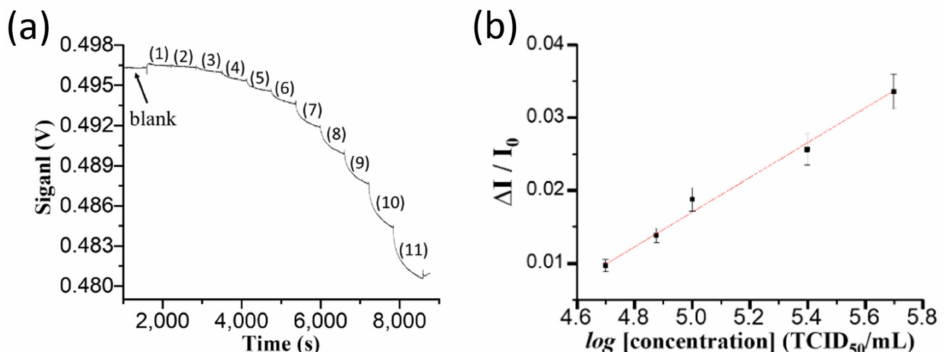
Figure 2. ( a ) The sensorgram obtained by sequentially injecting NNV standard solutions at concentra- tion of (1) 1.0 × 10 3 , (2) 2.5 × 10 3 , (3) 5.0 × 10 3 , (4) 7.5 × 10 3 , (5) 1.0 × 10 4 , (6) 2.5 × 10 4 , (7) 5.0 × 10 4 , (8) 7.5 × 10 4 , (9) 1.0 × 10 5 , (10) 2.5 × 10 5 , and (11) 5.0 × 10 5 TCID 50 /mL. ( b ) The standard calibration curve of the normalized response ( ∆ I/I 0 ) versus the logarithm value of NNV concentration (log[C]). Each point is the mean of 3 repeated